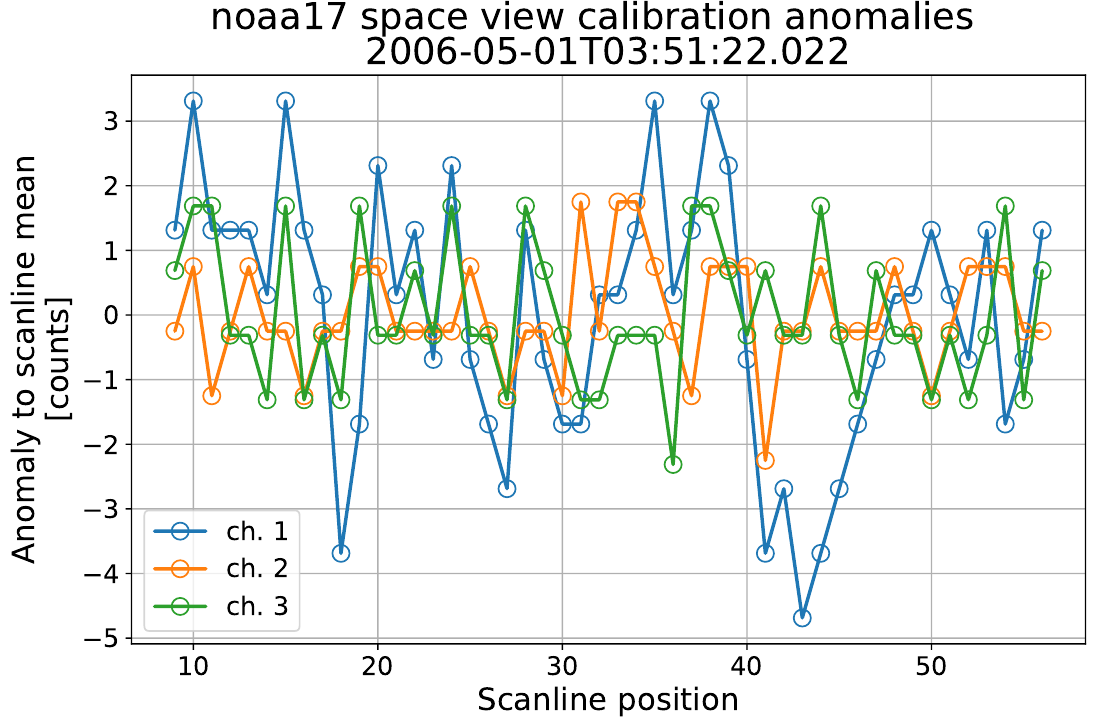
Figure 1. Example of space view deviations for one set of calibration measurements for channels